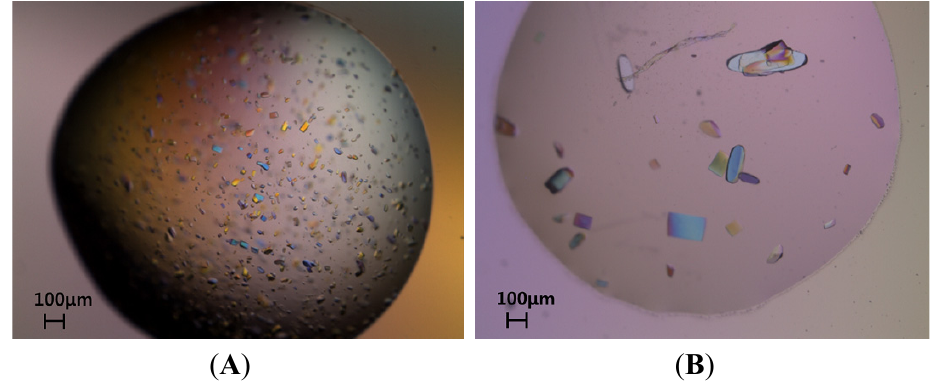
Figure 2. Crystals of C165S mutant Oxi- α . ( A ) Rice-shape crystals crystallized in 0.1 M sodium acetate pH 4.6, 1.0 M ammonium sulfate. The crystals grew to approximate dimensions of 0.10 × 0.10 × 0.02 mm in a week; ( B ) High-quality crystals crystallized in 0.1 M Bis-Tris propane pH 7.7, 1.2 M sodium citrate. These crystals grew to approximate dimensions of 0.50 × 0.25 × 0.10 mm in a week.